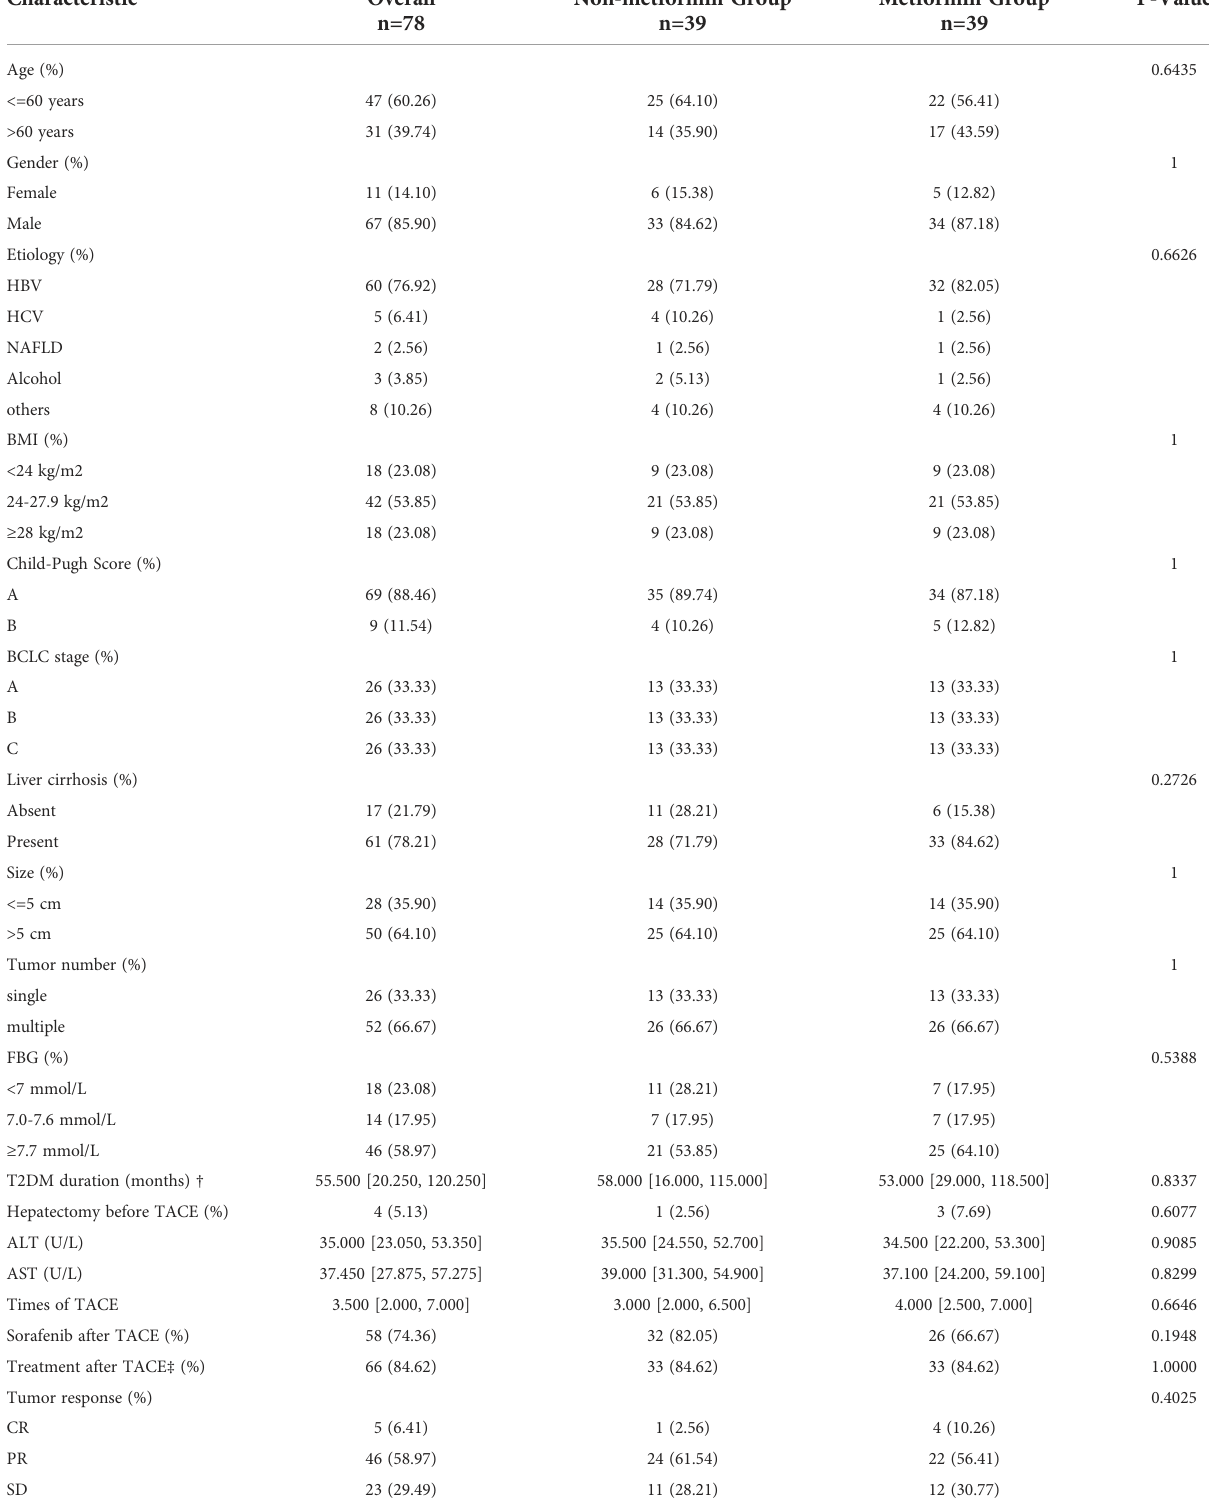
TABLE 3 Clinical characteristics between the metformin group and the non-metformin group of matched